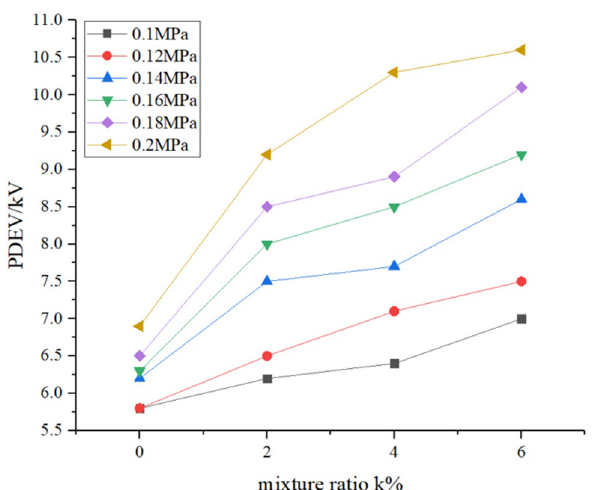
Figure 8. PDEV with the mixing